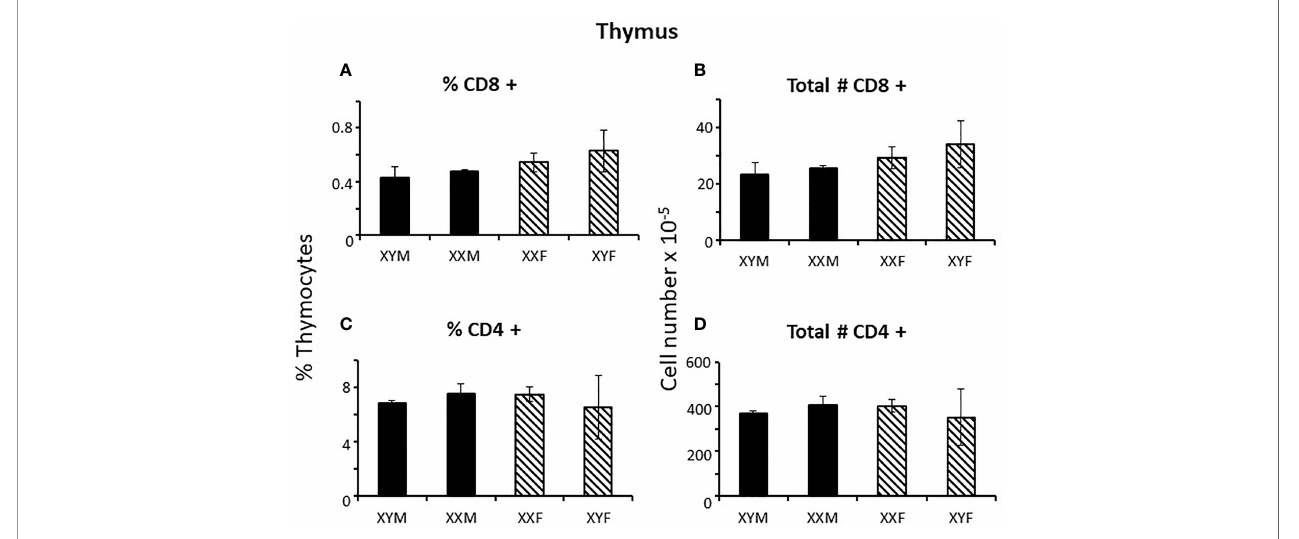
FIGURE 2 | Cellular content (percentages and numbers) of adult FCG thymi 4 weeks after gonadectomy. Data are presented as a percentage of gated thymocytes (mean ± SD) and are derived from 3-5 animals per